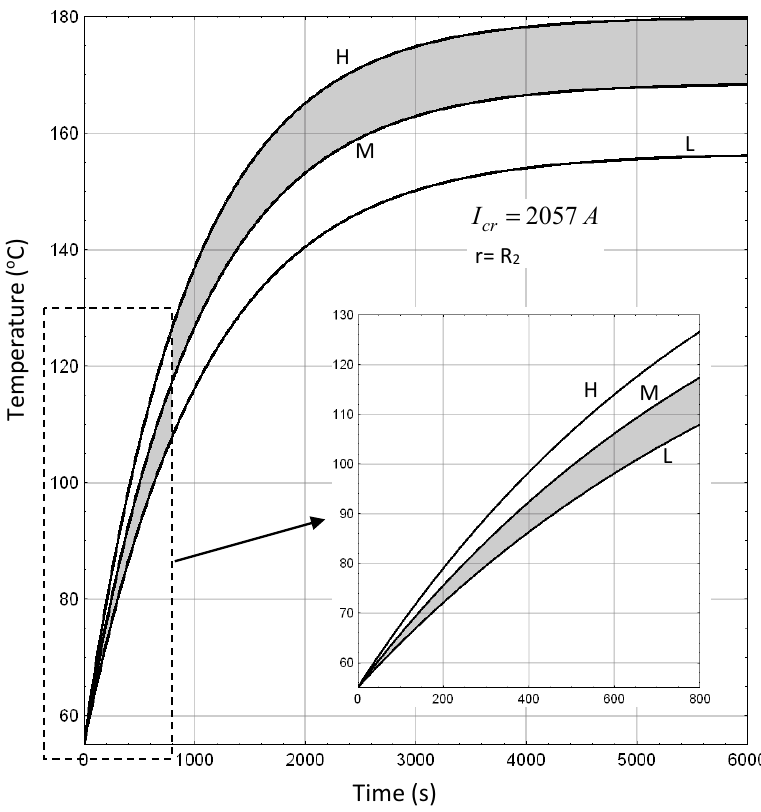
Figure 2. Lower and upper estimation of the heating curve T 3 ( r = R 2 , t ) with the current load I cr = 2057